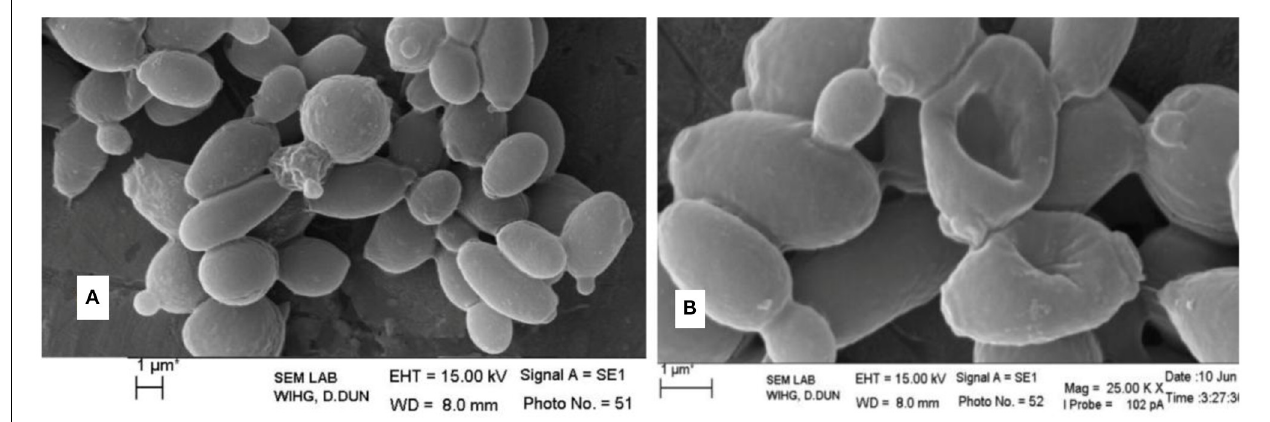
FIGURE 3 | Effect of antifungal metabolite on Candida albicans cells; (A) without treatment; (B) treatment with active metabolite produced by MN 2(6).